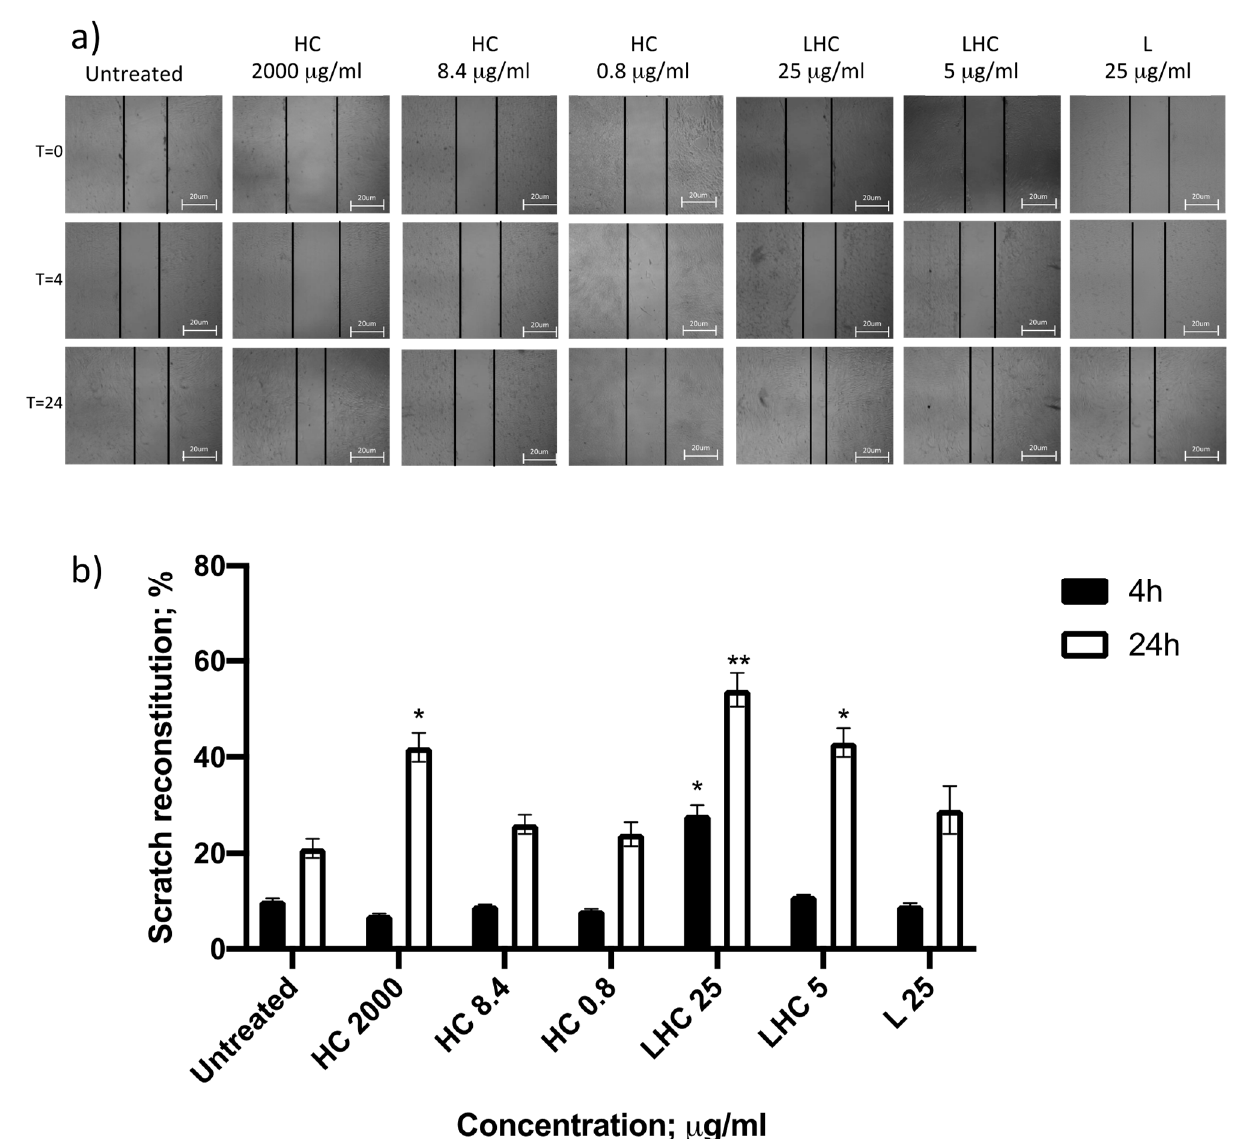
Figure 5. Evaluation of HC, LHC and L treatment on wound healing recovery in MRC-5 cells with images ( a ) and graphical representation ( b ) at the indicated time points. Data are the mean % of three independent experiments ± SD. * p < 0.05 and ** p < 0.01